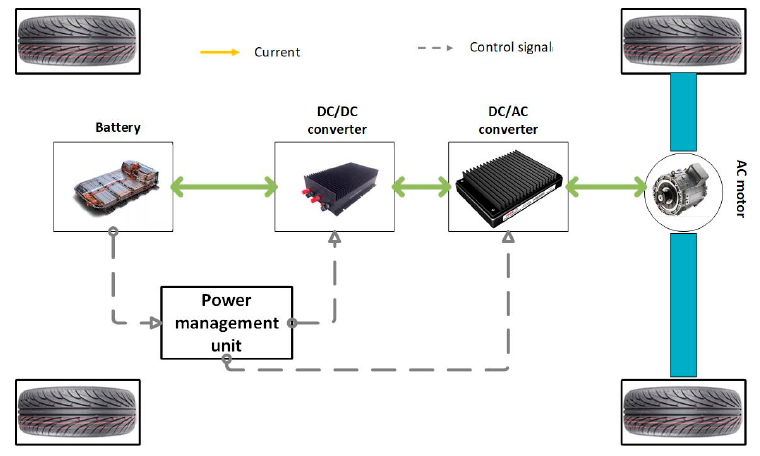
Figure 7. Battery electric vehicle (BEV) power system structure model.